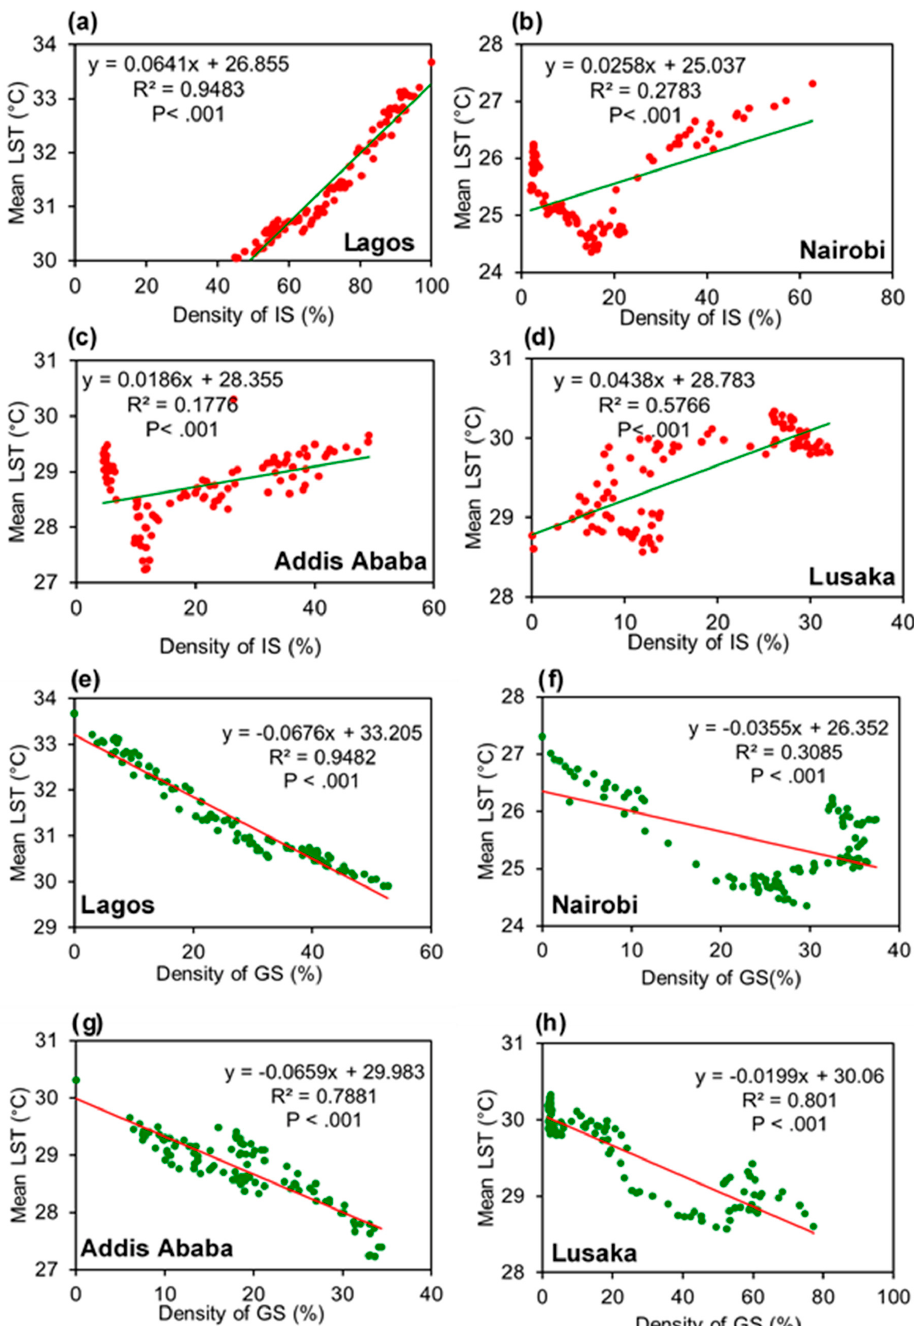
Figure 7. Correlation between mean LST and density of impervious surfaces ( a )–( d ) and green spaces ( e )–( h ).